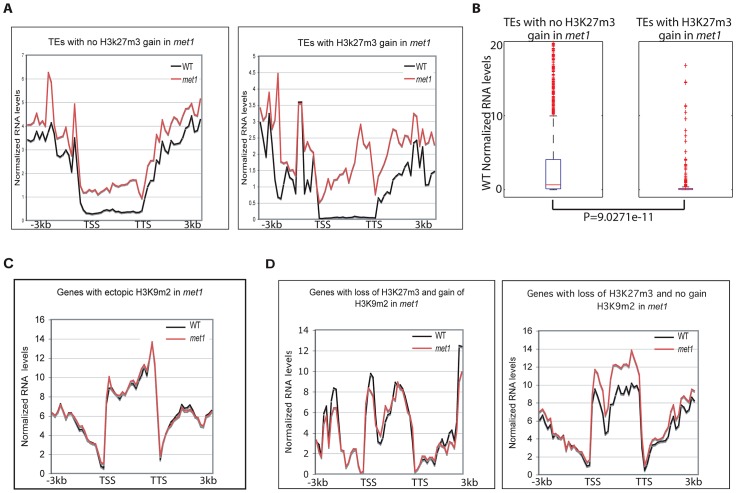
Genome-wide expression analyses.A. Transposable element expression levels in WT and met1 backgrounds (represented as RPKM). B. Wild-type expression levels of transposable elements that gain or do not gain H3K27m3 in met1. The red line represents the median; the edges of the box represents the 25th and 75th percentiles, the whiskers stretch out to 1.5× interquartile range above and below the edges of the box; the red dots represent the outliers. Transposable elements with RPKM = 0 were removed when generating boxplots. Two-tailed p-values were calculated by Wilcoxon ranksum test. C. Expression levels of protein-coding genes in WT and met1 at H3K9m2 hypermethylated genes. D. Expression levels of protein-coding genes in WT and met1 at H3K27m3-marked genes.